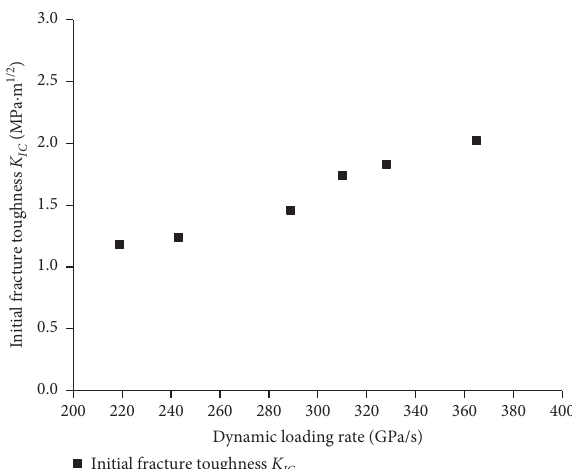
Figure 10: Relationship between the initial fracture toughness of the specimen and the dynamic loading horizontally to the left is the positive direction of X , while vertically downward is the positive direction of Y . The